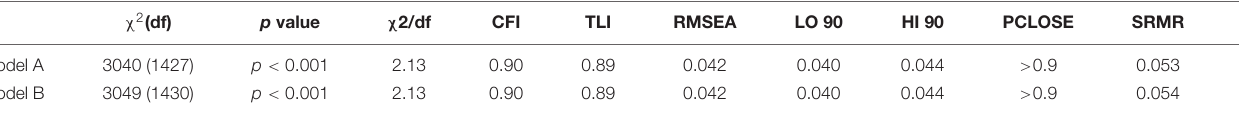
TABLE 3 | Goodness of fit indices for the mediation SEM Models A and B. χ 2 (df) p value χ 2/df CFI